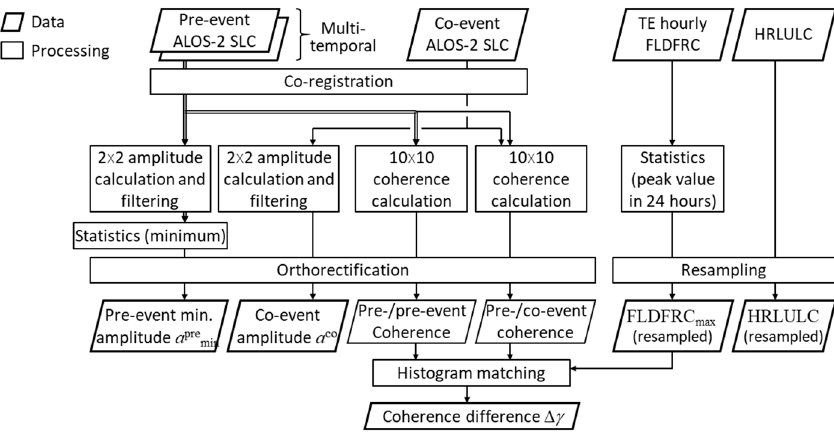
Figure 3. Flowchart showing the pre-processing of this study.